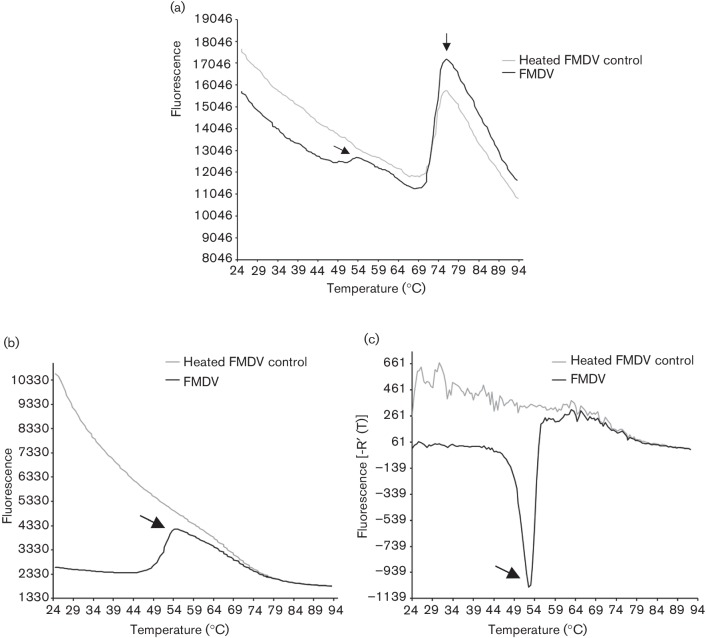
FMDV capsid integrity can be monitored by PaSTRy. (a) Dissociation curves performed at pH 7.4 for pre-heated (56 °C for 10 min) or non-heated FMDV (O1M), determined by hydrophobicity assay which detects unfolding of capsid proteins over a temperature gradient. Arrows indicate two separate dissociation peaks in the non-heated sample with corresponding Tm of 52.5 °C and 73.5 °C. (b) Dissociation curves performed at pH 7.4 for pre-heated (56 °C for 10 min) or non-heated FMDV (O1M), determined by RNA release assay, which detects release of viral genome over a temperature gradient. Arrow indicates a single dissociation peak with a corresponding Tm of 52 °C. (c) Data in (b) presented as a negative first-derivative plot.